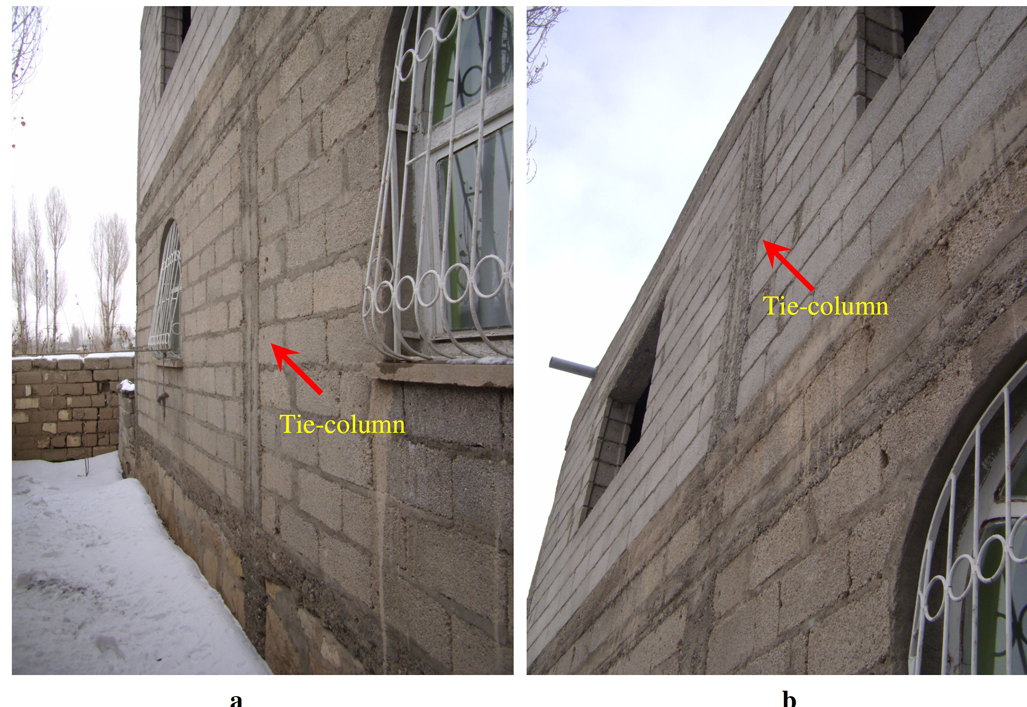
Fig. 26. Closer views of a confined masonry